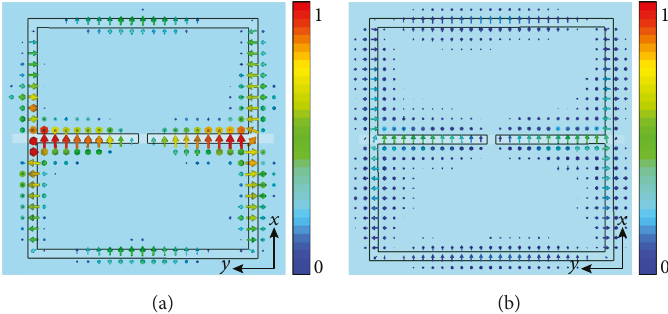
Figure 2: Electric fi eld distributions for the CELC resonator: (a) state “ ON, ” (b) state “ OFF. ”